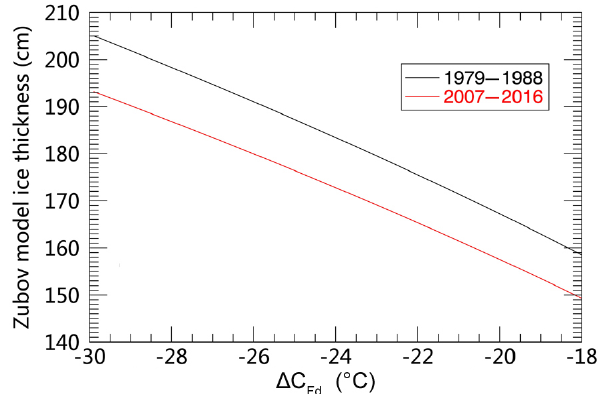
Figure 16. Modeled sea ice thickness change as a function of freez- ing degree (daily average, (cid:49)C Fd ) for early (1979–1987) and recent (2007–2016)